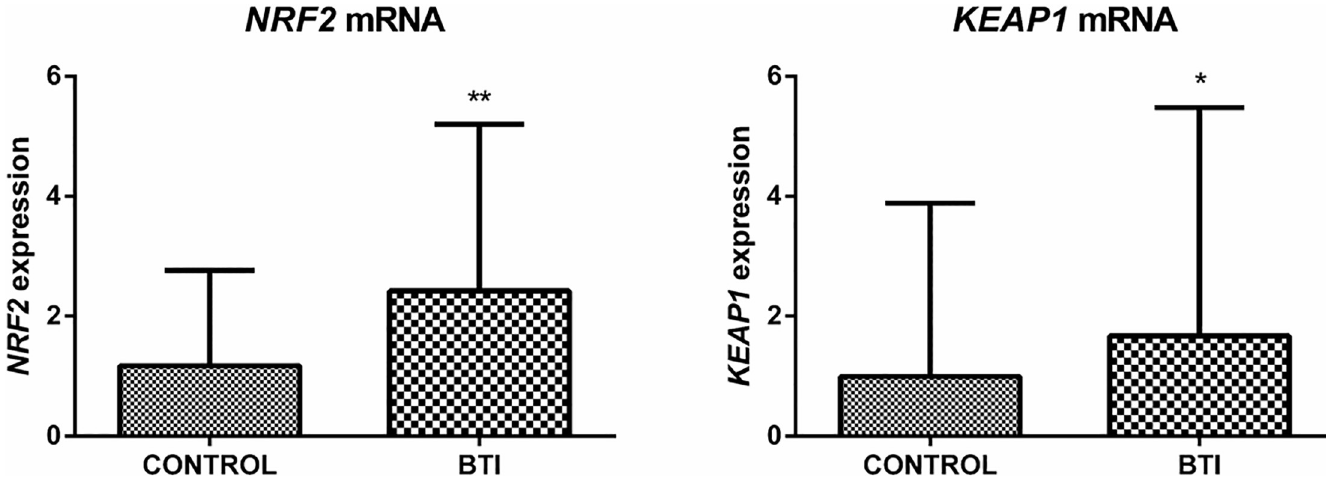
Fig 7. Analysis of the gene expression of Nrf2 and Keap1 in reticulocytes of BTI patients (n = 15) and healthy individuals (n = 16). RT-qPCR analyzes showed an increase in the gene expression of Nrf2 (approx. 3 fold change) and Keap1 (approx. 2 fold change) in the reticulocytes of the BTI group when compared to the control group. Primers used for these analyzes are described in S1 Table. mRNA abundance for each gene was normalized to Bac as the endogenous reference. Results are presented as mean and standard error ( ± SEM). Statistical significance: � p < 0.05, �� p < 0.001.